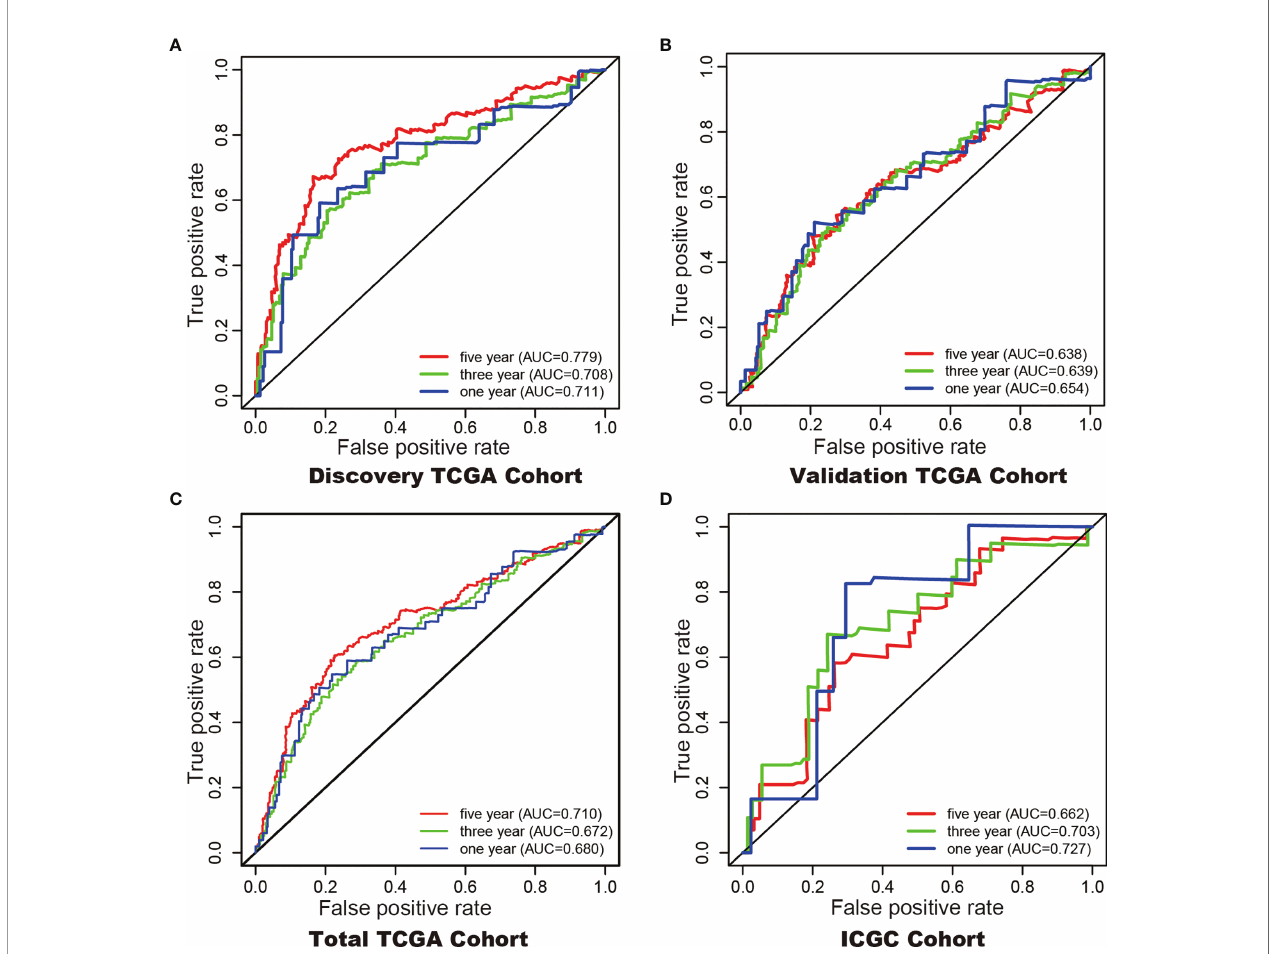
FIGURE 5 | ROC curves with calculated AUCs were established to evaluate the prognostic value of the 6-gene model in 5-, 3-, 1-years in the Discovery TCGA Cohort (A) , the Validation TCGA Cohort (B) , the Total TCGA Cohort (C) , and the ICGC Cohort (D)